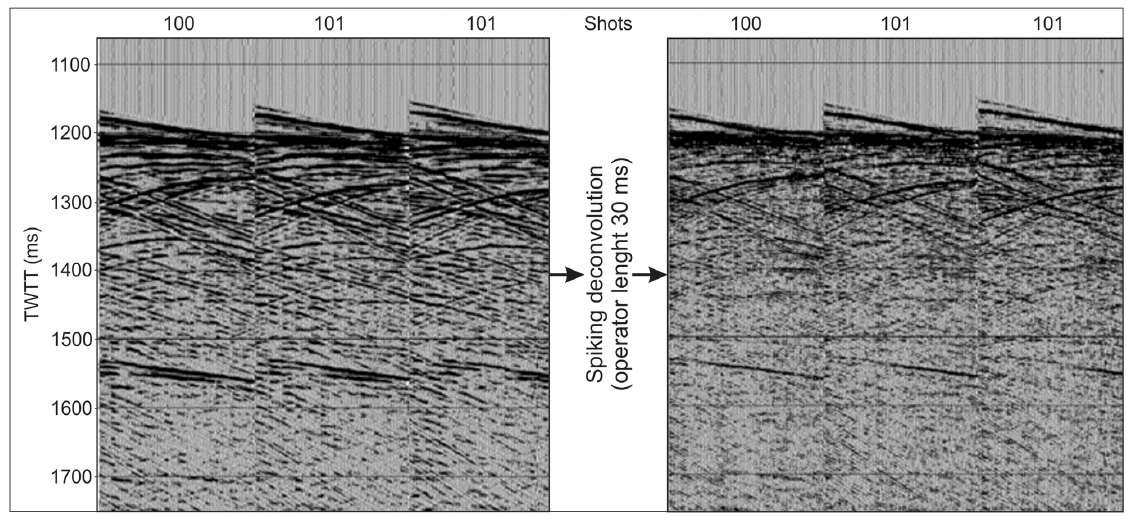
Figure 9. Effects of spiking deconvolution (right) on three pre-processed shots (left) of the line L_I02_HR (Ionian Sea), using an operator length of 30 ms (see text for further